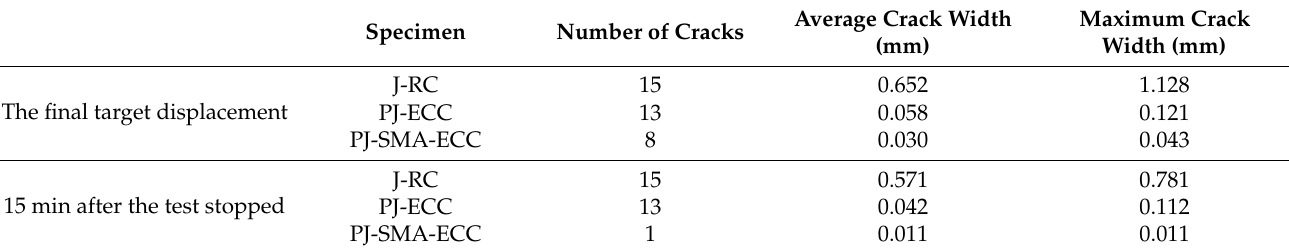
Figure 8. Measured maximum crack width in the joint zone vs. displacement for ( a ) J-RC and ( b ) PJ-ECC and PJ-SMA-ECC. Table 8. Crack measurements in the joint zone.